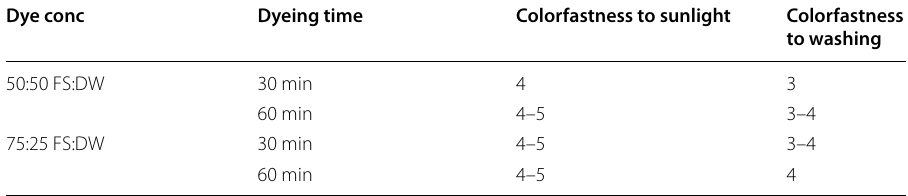
Table 14 Colorfastness grades of cotton dyed with hydrolyzed extract of Flos Sophorae Dye conc Dyeing time Colorfastness to